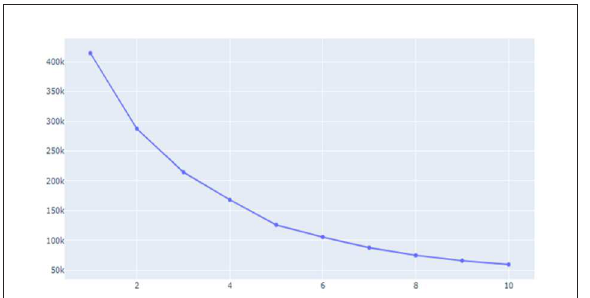
FIGURE9 Inertial value change according to the K -value